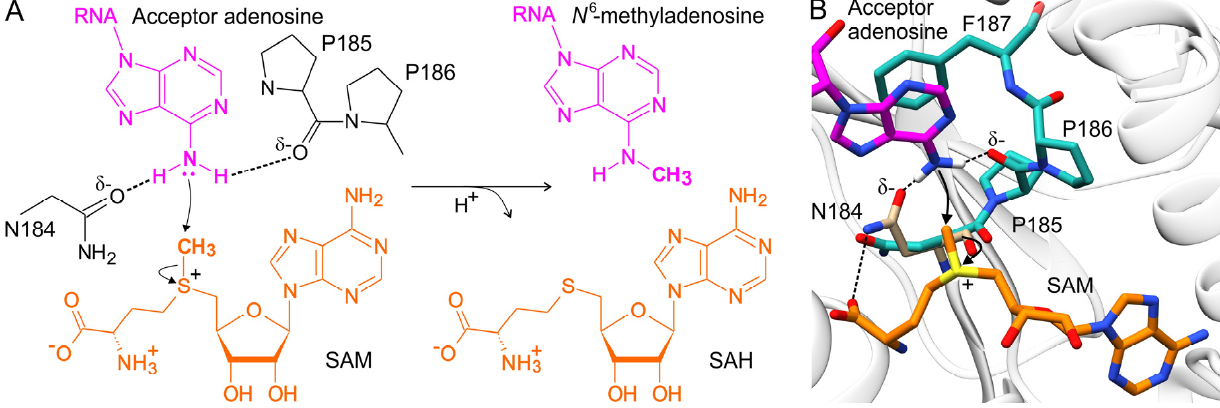
Figure 5. The mechanism of methyl transfer catalyzed by METTL16. ( A ) A graphical representation of methyl transfer mechanism from SAM to the N6 atom of acceptor adenosine ([29], figure modified). ( B ) To propose the course of the methyl transfer reaction, SAM (orange stick representation) was modeled into the SAH binding site of METTL16-MTD/SAH (2h00) and superimposed with the METTL16-MTD/hp1x complex (6du4; white hydrogen atoms are shown only for the N6 amino group). The catalytic motif of METTL16-MTD/hp1x is turquoise, F187 is in an optimal position to stack with the acceptor adenosine. The proper position of the N184 side chain (tan) is coordinated by SAH/SAM carboxyl and present only in the METTL16/SAH